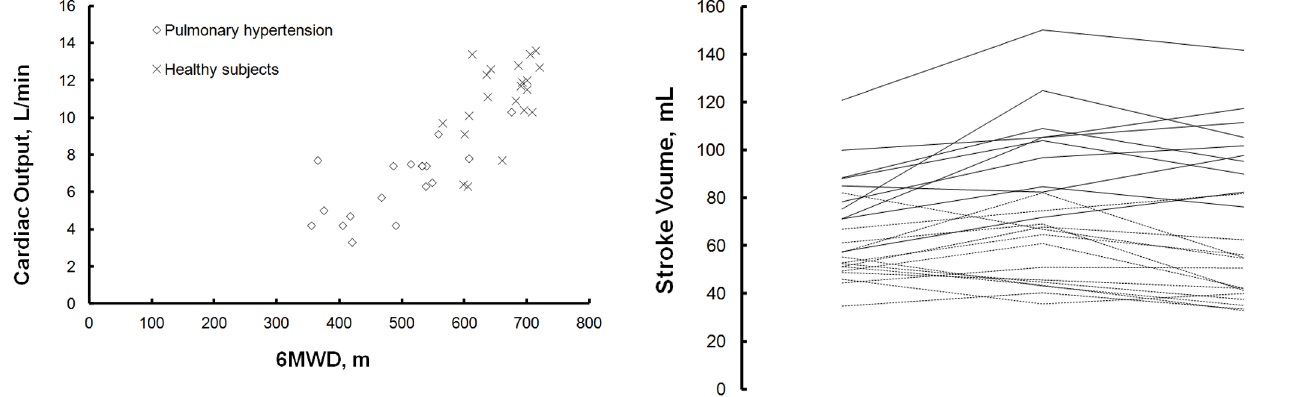
Figure 1. Cardiac output response to a 6MWT in relation with the 6MWD in 21 healthy subjects and 18 pulmonary hyper- tension patients.